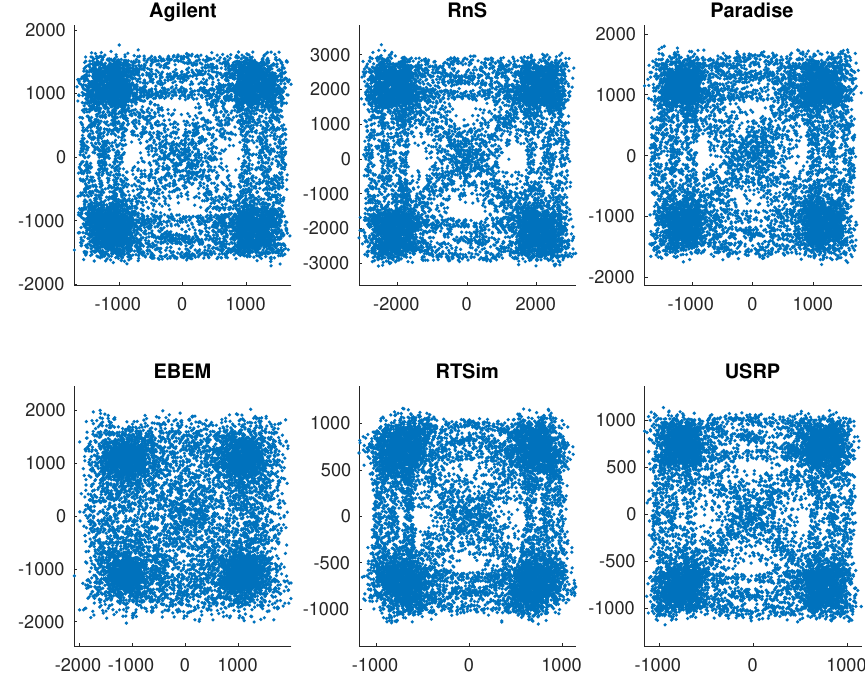
Figure 9. Six constellations from six different sources are corrected for phase and frequency offsets and used for training and testing. There is noise of unknown strength already in the data. Constellation similarities illustrate the difficulty of radiometric identification by feature